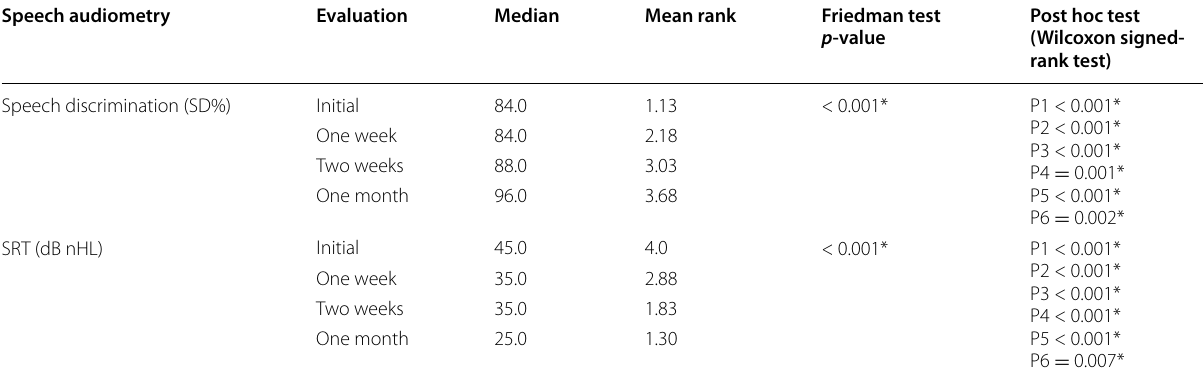
*Significant at p < 0.05. Pairwise comparison revealed significant differences ( P < 0.05*). P1, initial versus 1 week. P2, initial versus 2 weeks. P3, initial versus 1 month. P4, 1 week versus 2 weeks. P5, 1 week versus 1 month. P6, 2 weeks versus 1 month